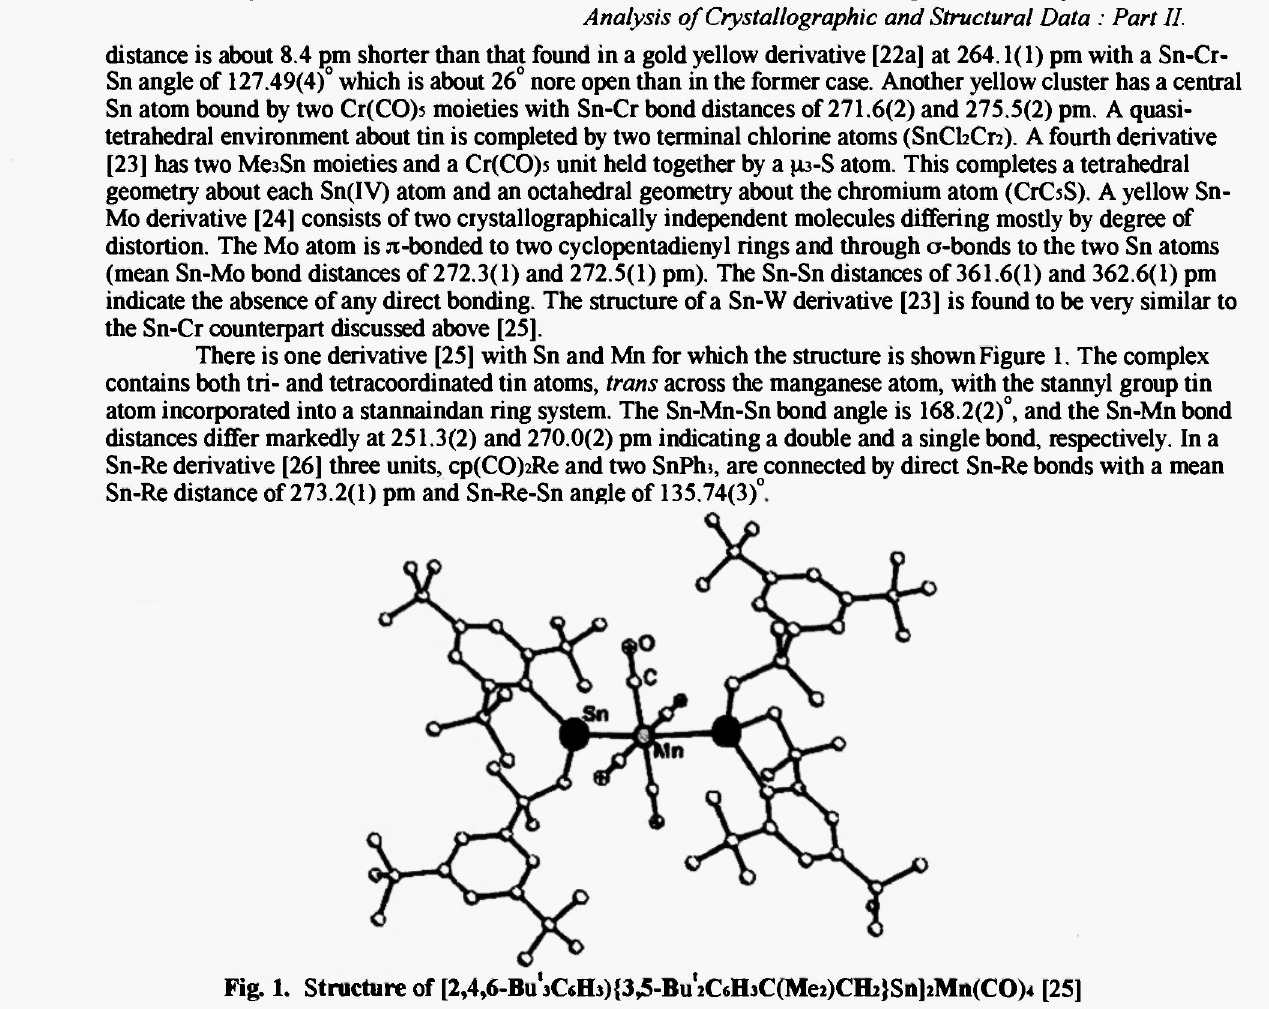
Fig. 1. Structure of [2,4 ,6 -Bu 'iCtHj){3 ^-Bu , 2C6HiC (Mei )CH2 }SnliMn (CO )4